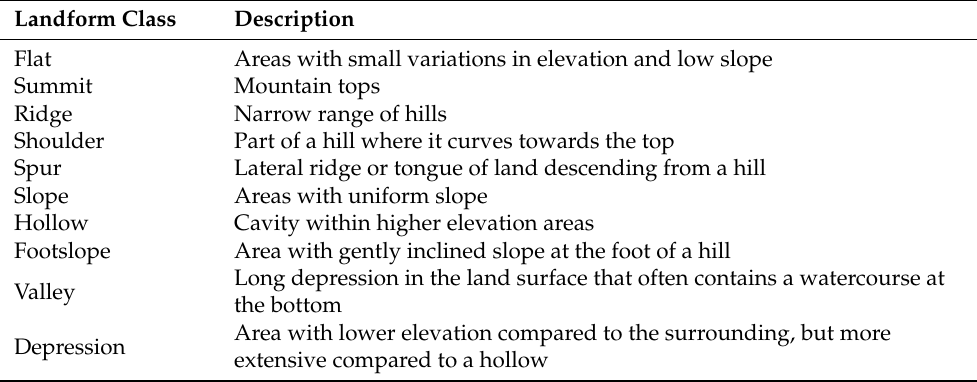
Table 2. Landform classes derived from the GRASS GIS package r.geomorphon